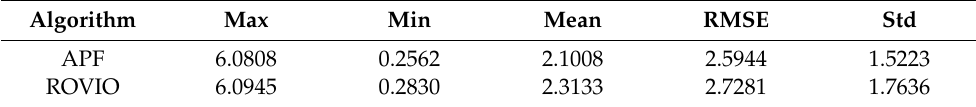
Table 4. Error analysis between the proposed algorithm and the ROVIO algorithm (pose: 29,993).